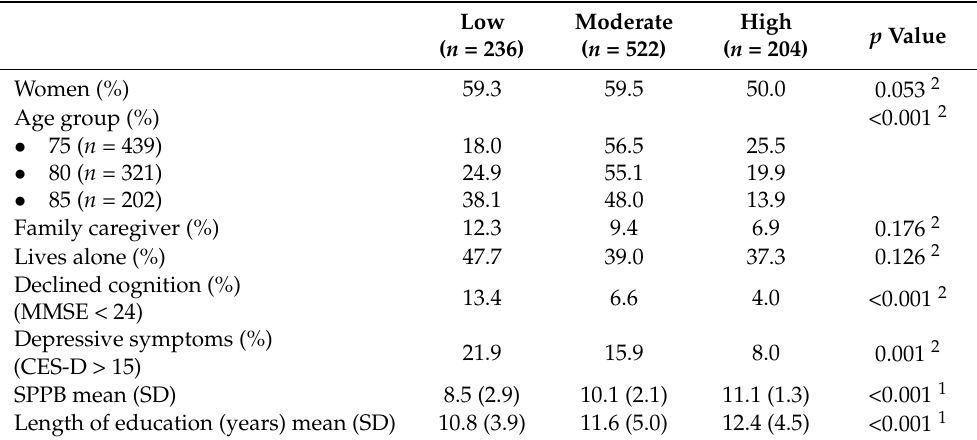
Table 1. Descriptive statistics according to physical activity